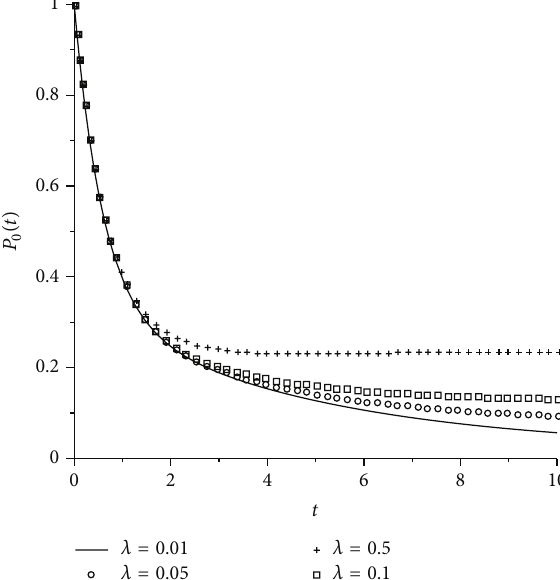
Figure 2: Instantaneous probabilities of the system with warning device in good state with different 𝜆